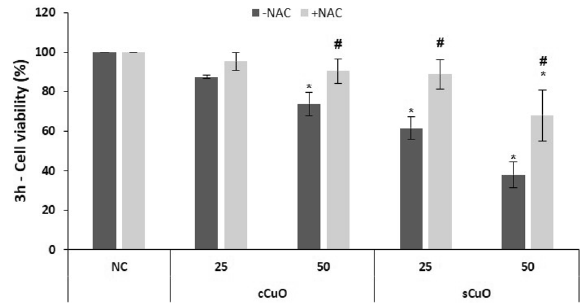
Figure 5. Cell viability results by MTT assay of A549 co-incubated with a ROS scavenger. Cells were exposed to copper oxide nanoparticles for 3 h in presence of 10 mM NAC (+ NAC, light grey bars) or without (-NAC, dark grey bars). Results are expressed as mean ± SD. *Significantly different from the negative control (NC) (ANOVA + Fischer LSD test; p < 0,05). # Significantly different from the correspondent experimental group without NAC (t-test, p = 0,002).